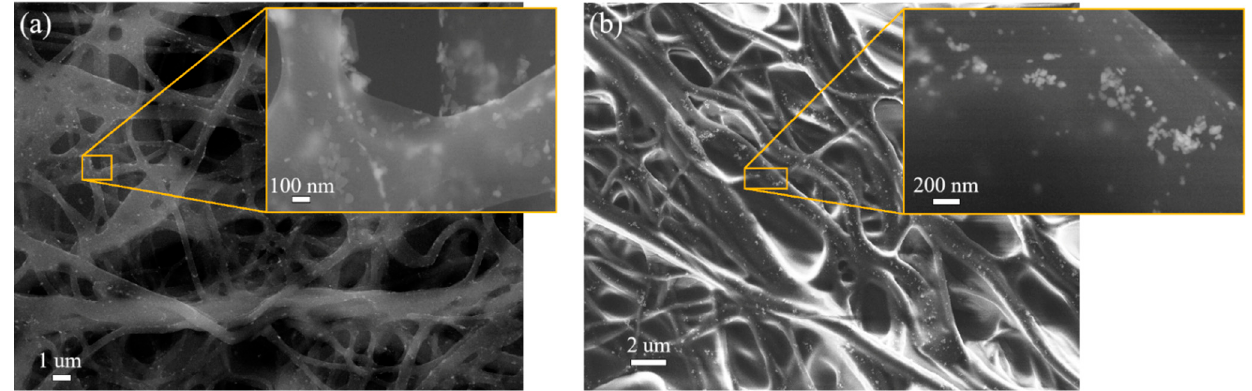
Figure 9. SEM microphotograph of PVA–AgNPs composite. Dip-coating technique, sample B ( a ) and the sample I ( b ).